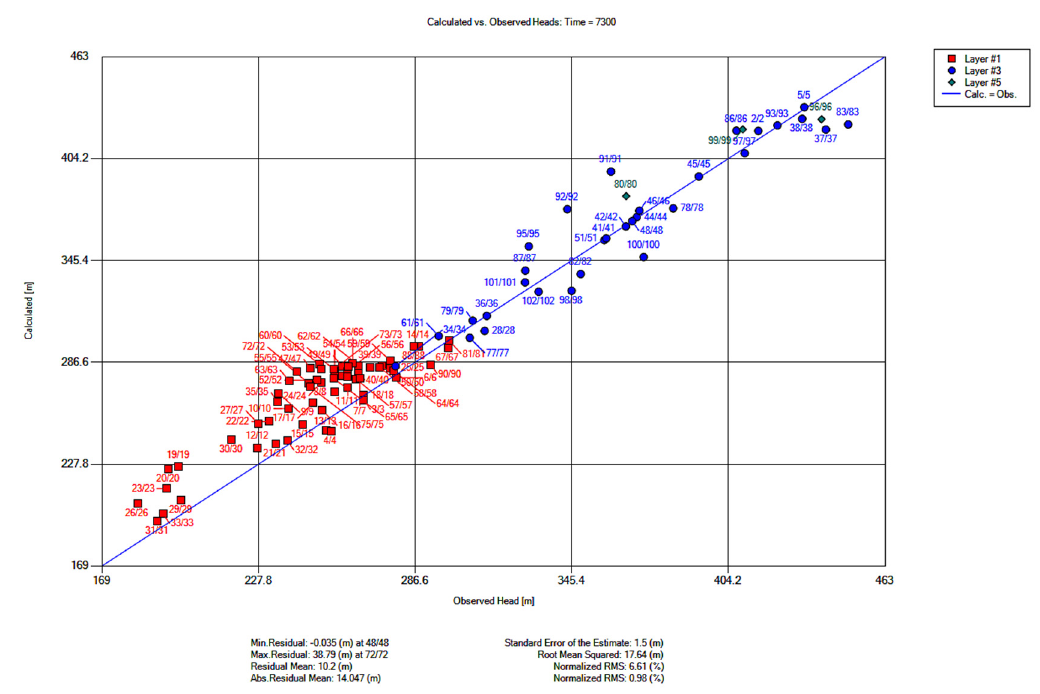
Figure 9. Plots residuals of the model three after correction. Table 4. Optimized hydraulic conductivity.